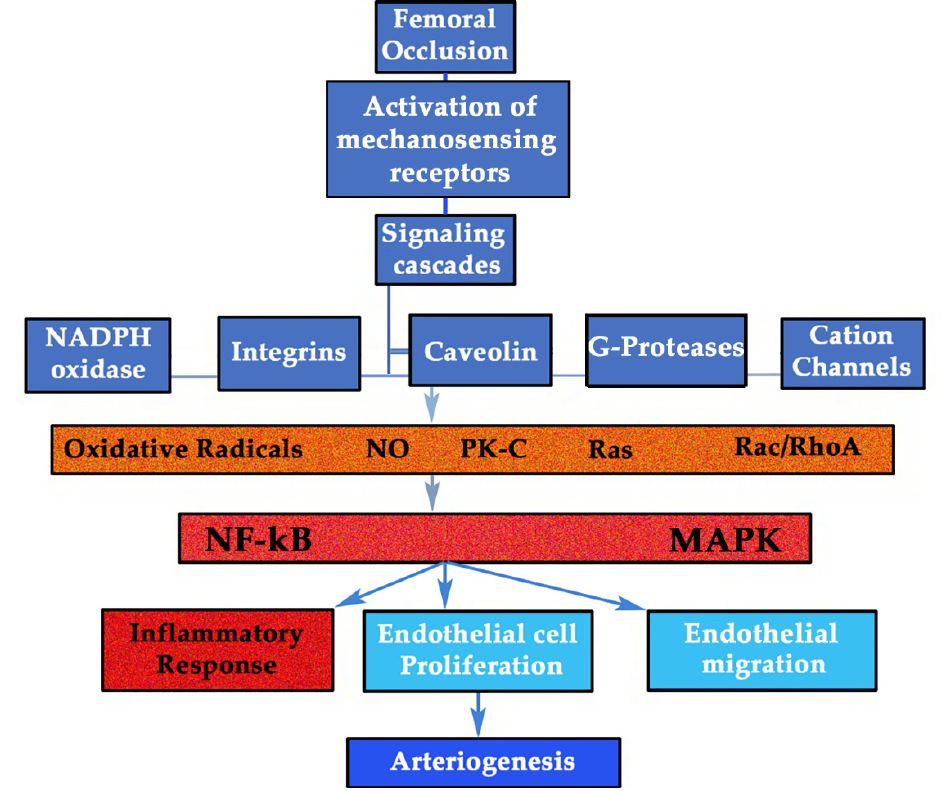
Figure 4. Signaling cascades for collateral growth: The redox system can play a very important role. Schematic representation of signaling cascades after an arterial occlusion, triggering both the inflammatory response and the phenomena of the proliferation and migration of endothelial cells into the artery media layer. Several pathways have been highlighted: Rho, involved in endothelial cells proliferation; Ras, for endothelial cells migration; and NO, for endothelial function and monocytes adhesion. The oxidative radicals produced in cellular metabolism are currently considered very important in the stimulation of the NO pathway for vascular homeostasis. They control NO bioavailability. The Rho pathway has been advocated as crucial for sensing of SSF. Caveolins: family of integral membrane proteins that play a role in the signaling of integrins and in the migration of endothelial cells. Cation channels, mainly the Ca 2 + ion, are also related to the activation of Protein kinase C (PKC) and the RAS / RAC (rats’ sarcoma-extracellular signal-regulated kinases / Ras-related C3 botulinum toxin substrate). All signaling cascades are activated by SSF. For more details,